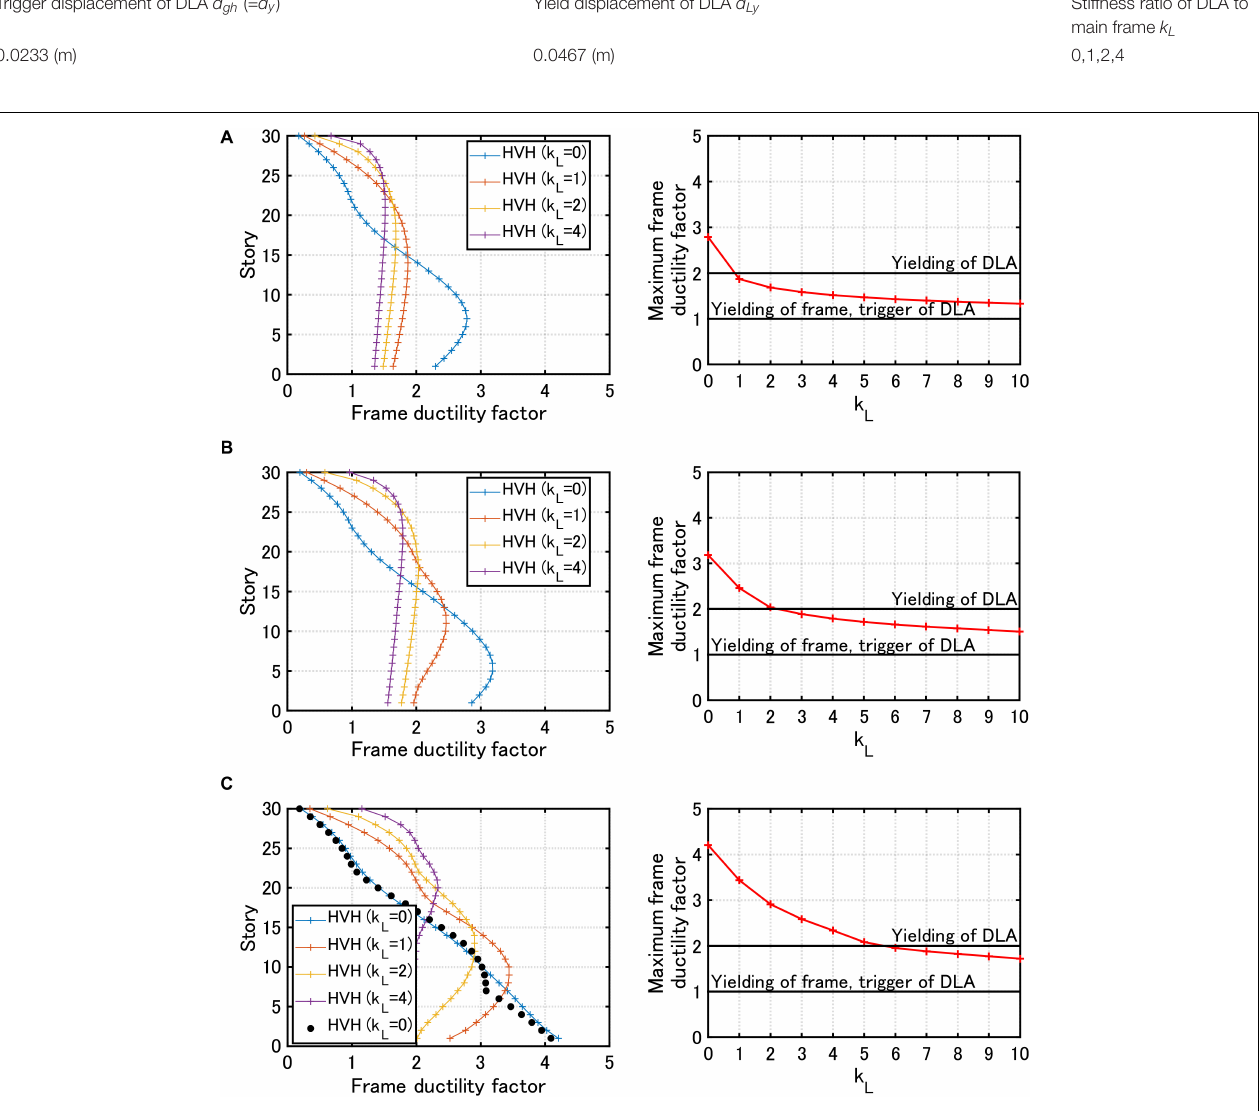
FIGURE 3 | Frame ductility factor distribution of inter-story drift for various stiffness ratios k L = 0, 1, 2, 4 of the hysteretic damper (DLA) to the main frame (left) and maximum frame ductility factor with respect to k L (right) in the MDOF system with the HVH system under critical double impulse, (A) Velocity level of double impulse V = 1.0 (m/s), (B) V = 1.5 (m/s), (C) V = 2.0 (m/s) (solid black circles indicate responses to corresponding one-cycle sine wave).